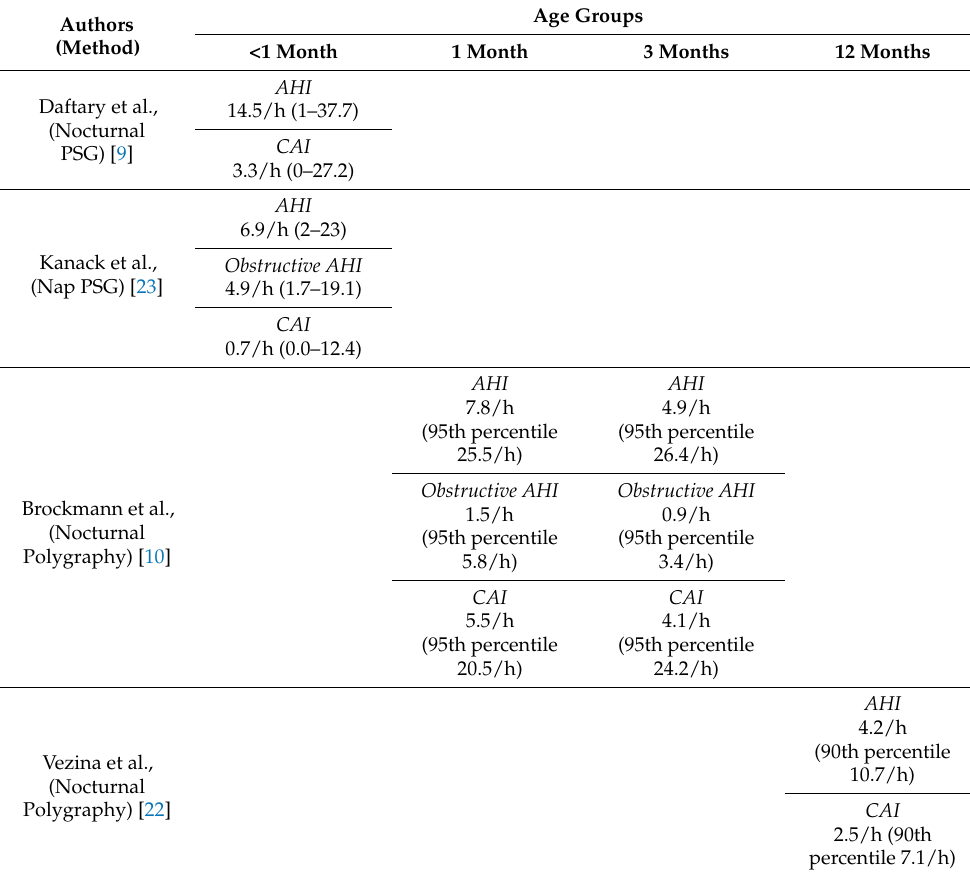
Table 1. Comparison of reference values for apnea hypopnea index, obstructive apnea-hypopnea index, and central apnea index from various studies that recruited healthy infants and used AASM scoring